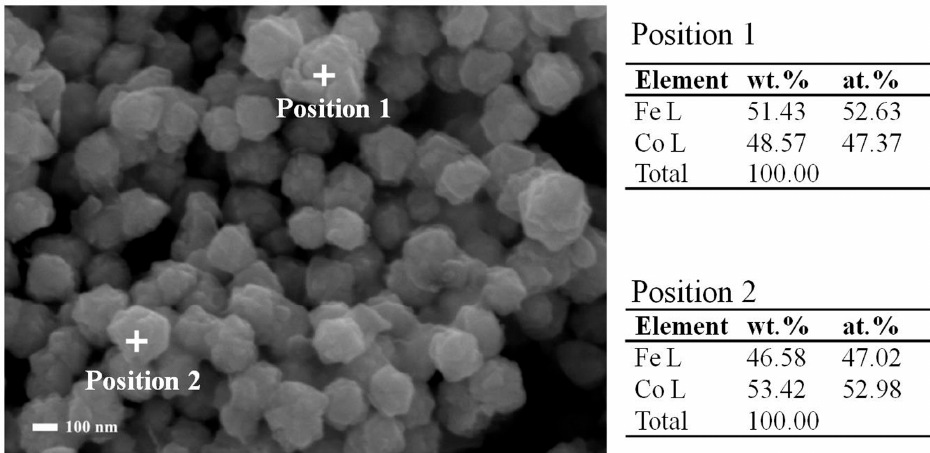
Figure 2. SEM and EDS of FeCo single-phase Solid Solution.